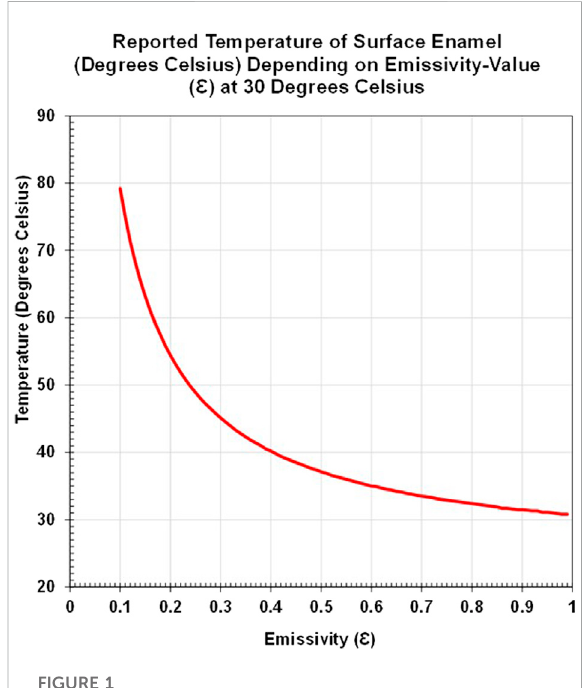
FIGURE 1 Linegraphofchangingtemperaturewithemissivityofhuman enamel at 30 °